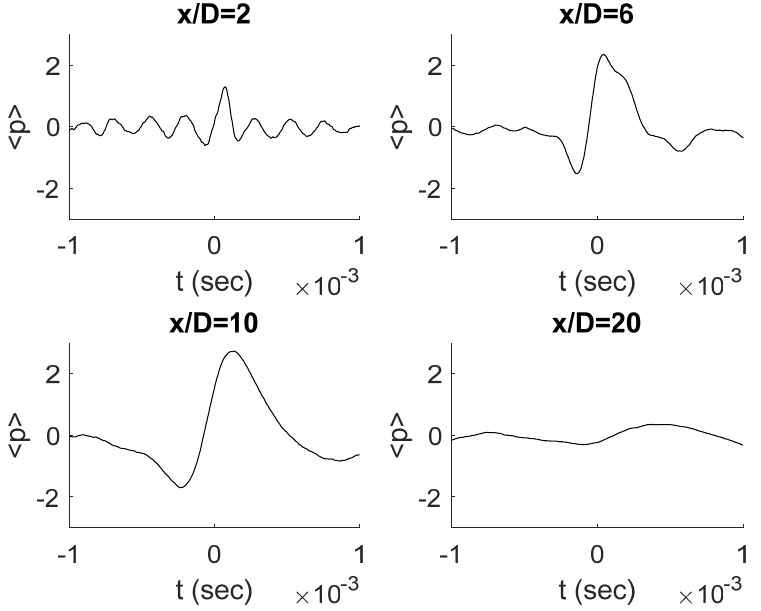
Figure 3. Examples of averaged pressure obtained from the conditional sampling procedure carried out at r/D = 1 and M = 0.5.